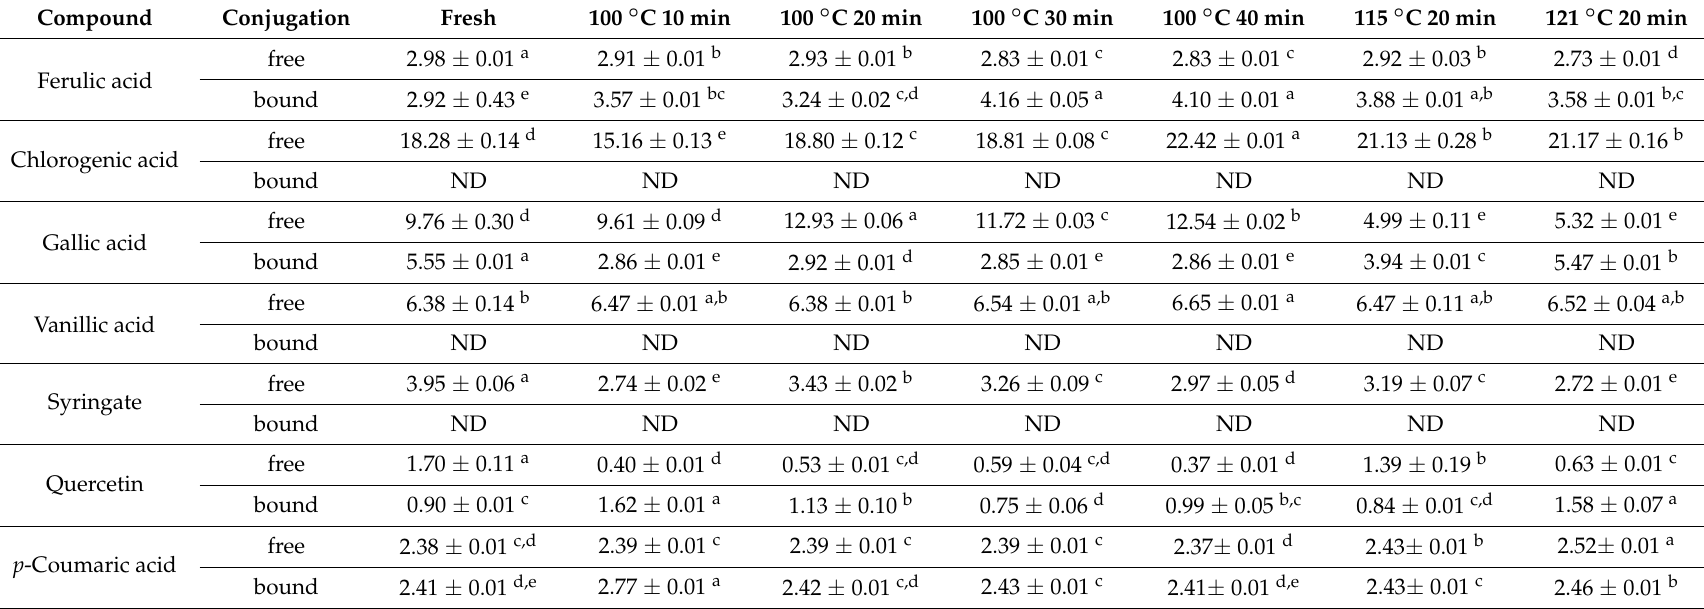
Table 1. Changes of phytochemical profiles in chestnut fruits after thermal